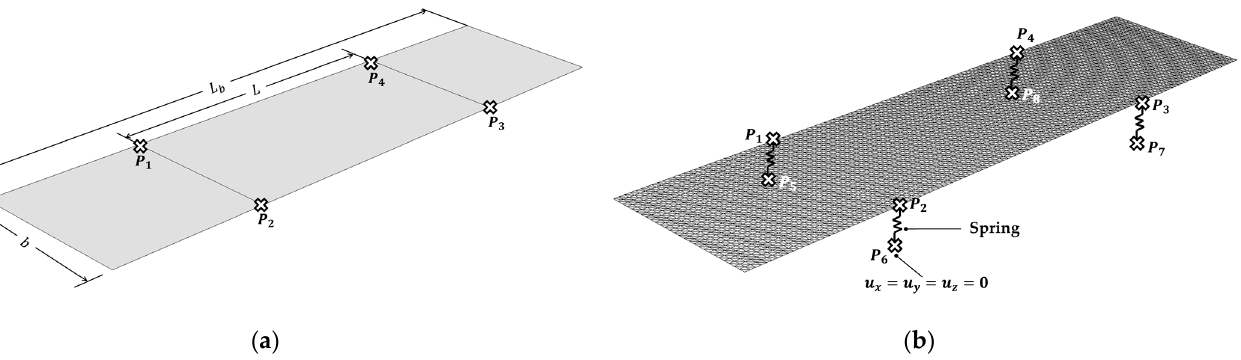
Figure 8. Numerical model; ( a ) geometrical perspective and ( b ) FE mesh, interactions and essential boundary condition presentation.